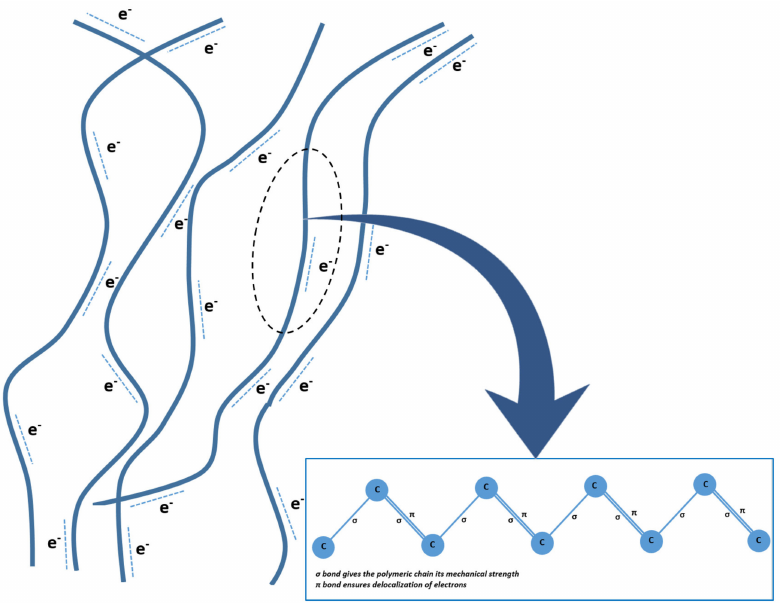
Figure 1. Schematic illustration of structure and charge transport mechanism in intrinsic conductive